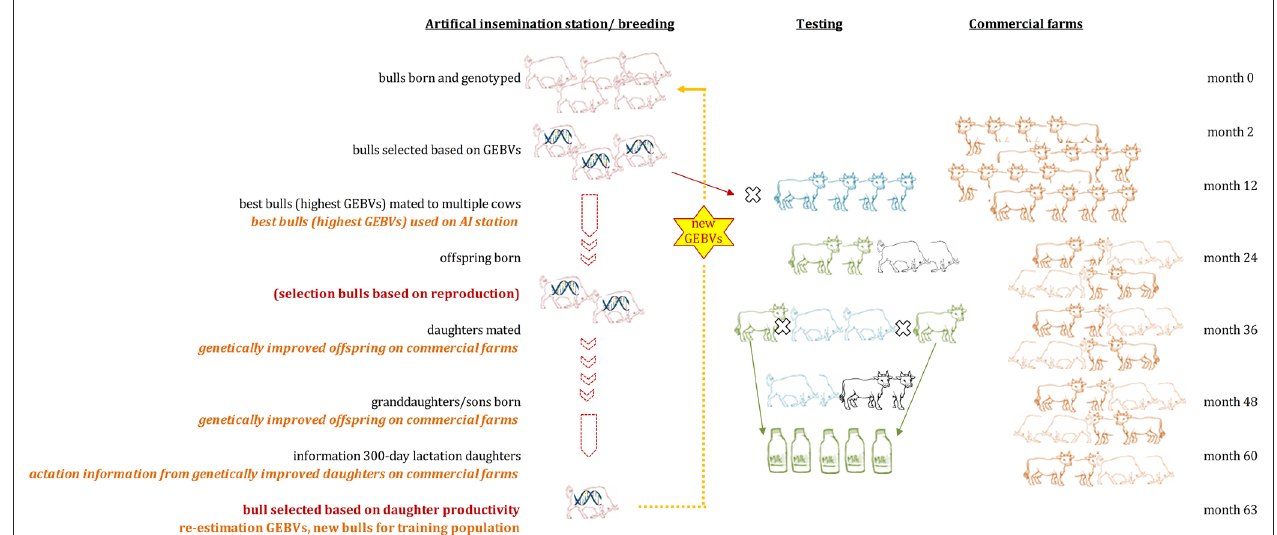
existing training population in month 0 and are being updated in month 63 with additional information. Only selected animals (based on GEBVs) are used for testing. Semen of superior bulls can be used earlier on commercial farms, allowing for higher genetic gain. Genomic selection allows a significant reduction of the generation interval from 6 to 1.5 years if applied as suggested in the